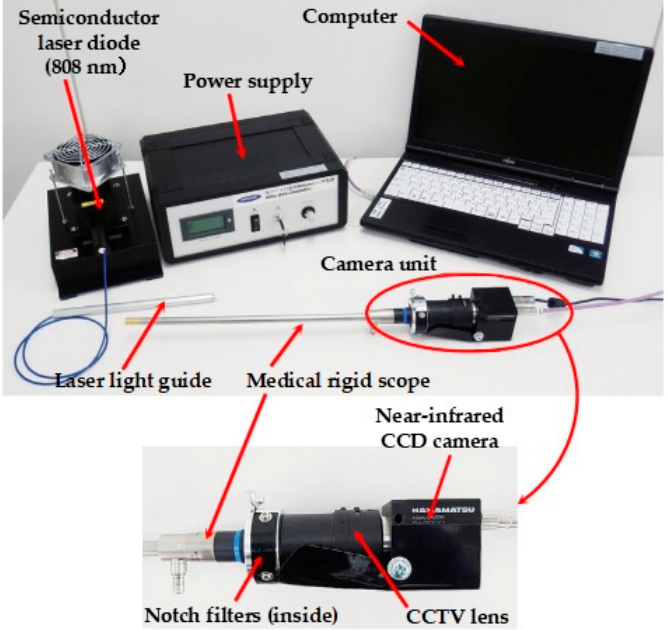
Figure 4. The laparoscopic fluorescent detection system composed of a medical rigid scope with a near-infrared CCD camera, a semiconductor laser diode (808 nm) as an excitation light source, and a computer with monitor.